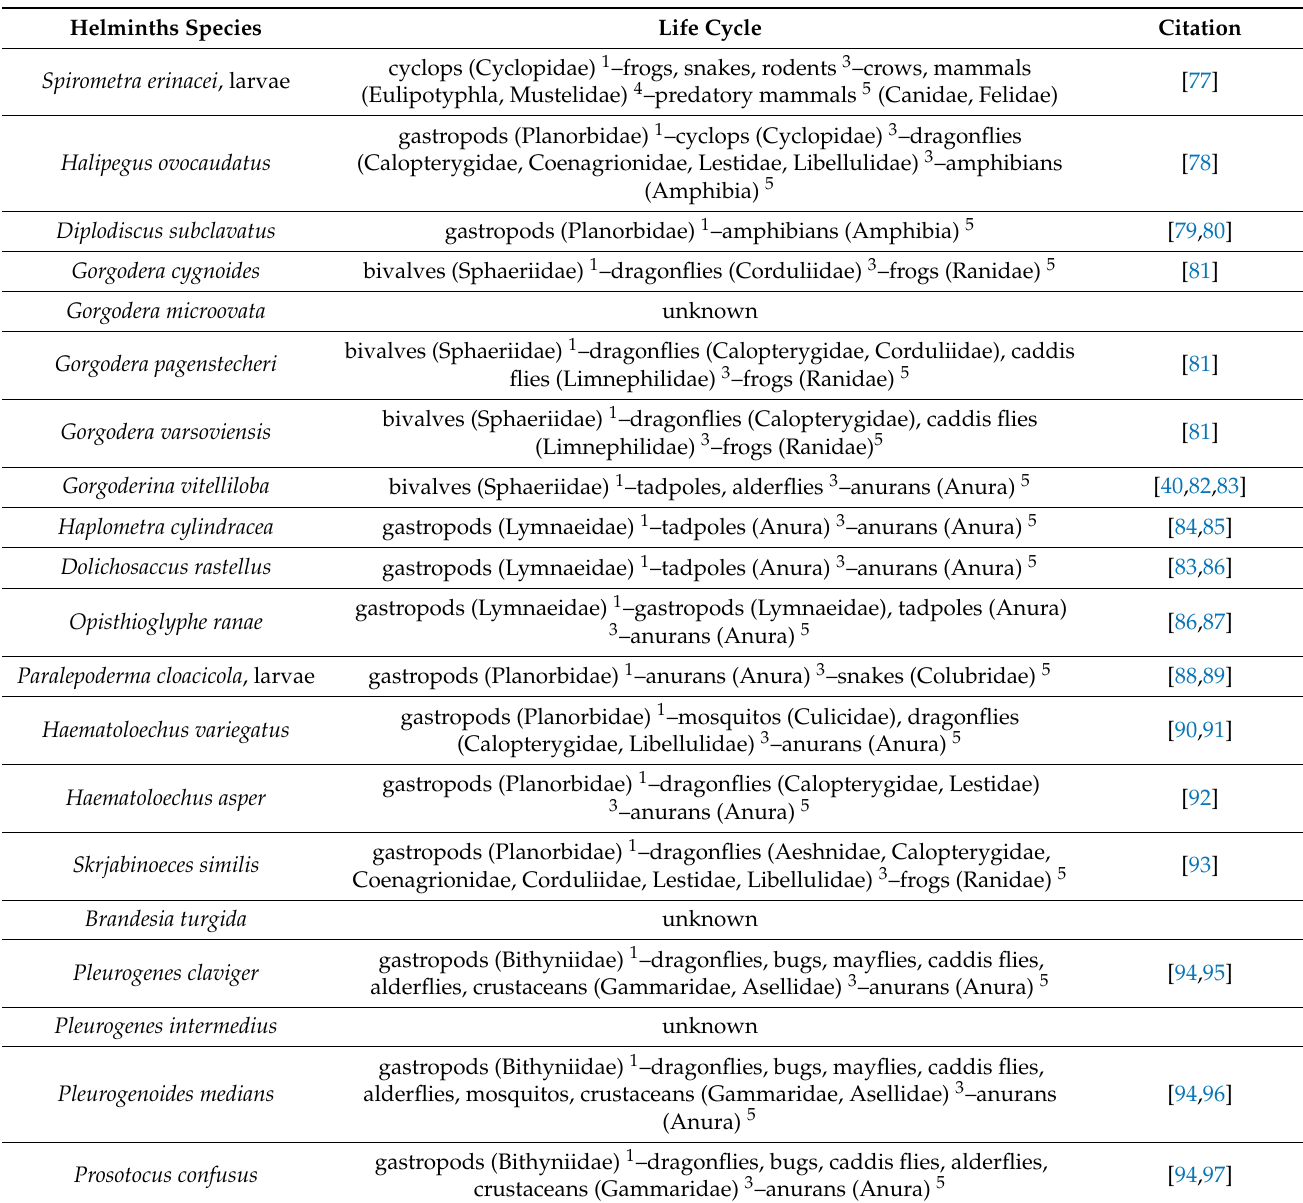
Table 2. Life cycles of helminths of a moor frog Rana